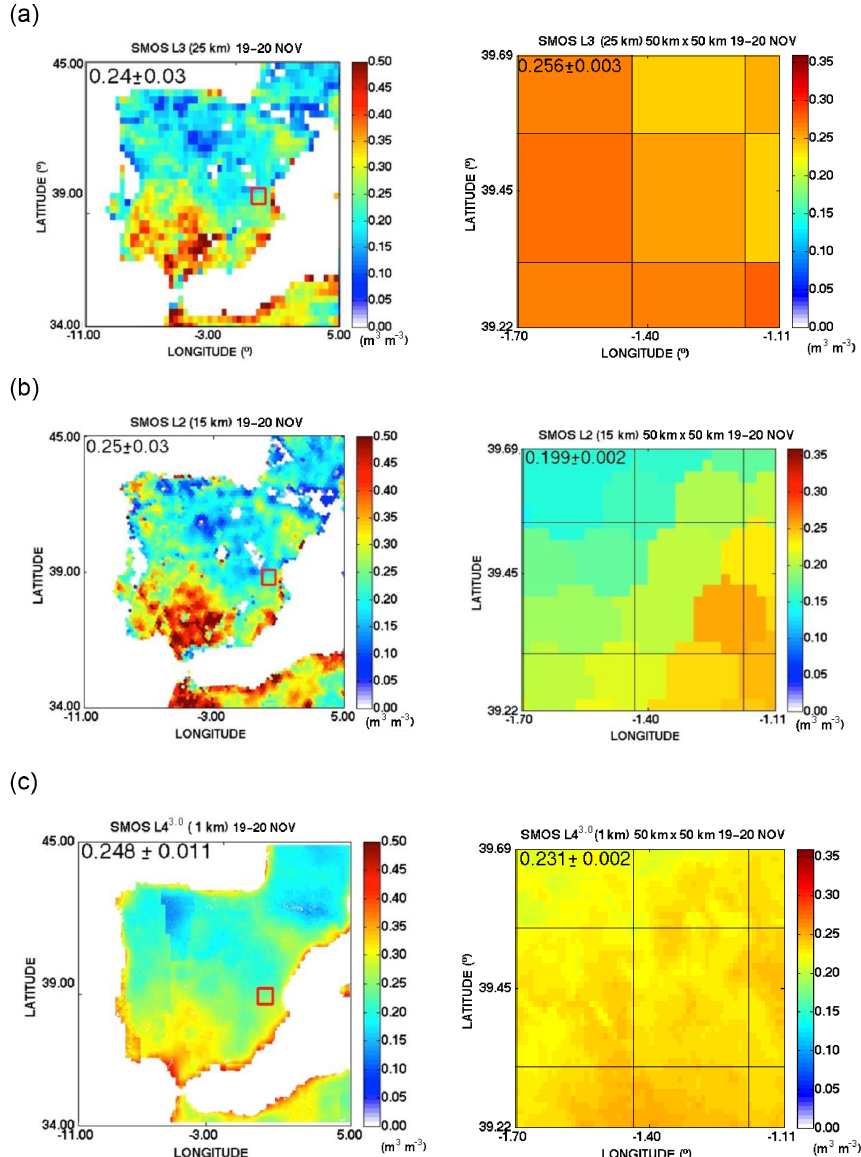
Figure 4. Spatial distribution of SMOS-derived soil moisture (merged product: ascending and descending orbits are considered) over the Iberian Peninsula (left) and the VAS (right) as a mean for the 19–20 November 2012 (a) SMOS-L3 ( ∼ 25km), (b) SMOS-L2 ( ∼ 15km) and (c) SMOS-L4 3 . 0 ( ∼ 1km). Empty pixels in (a) and (b) are indicative of a lack of data. Please be aware of the different colour scale used for the IP and